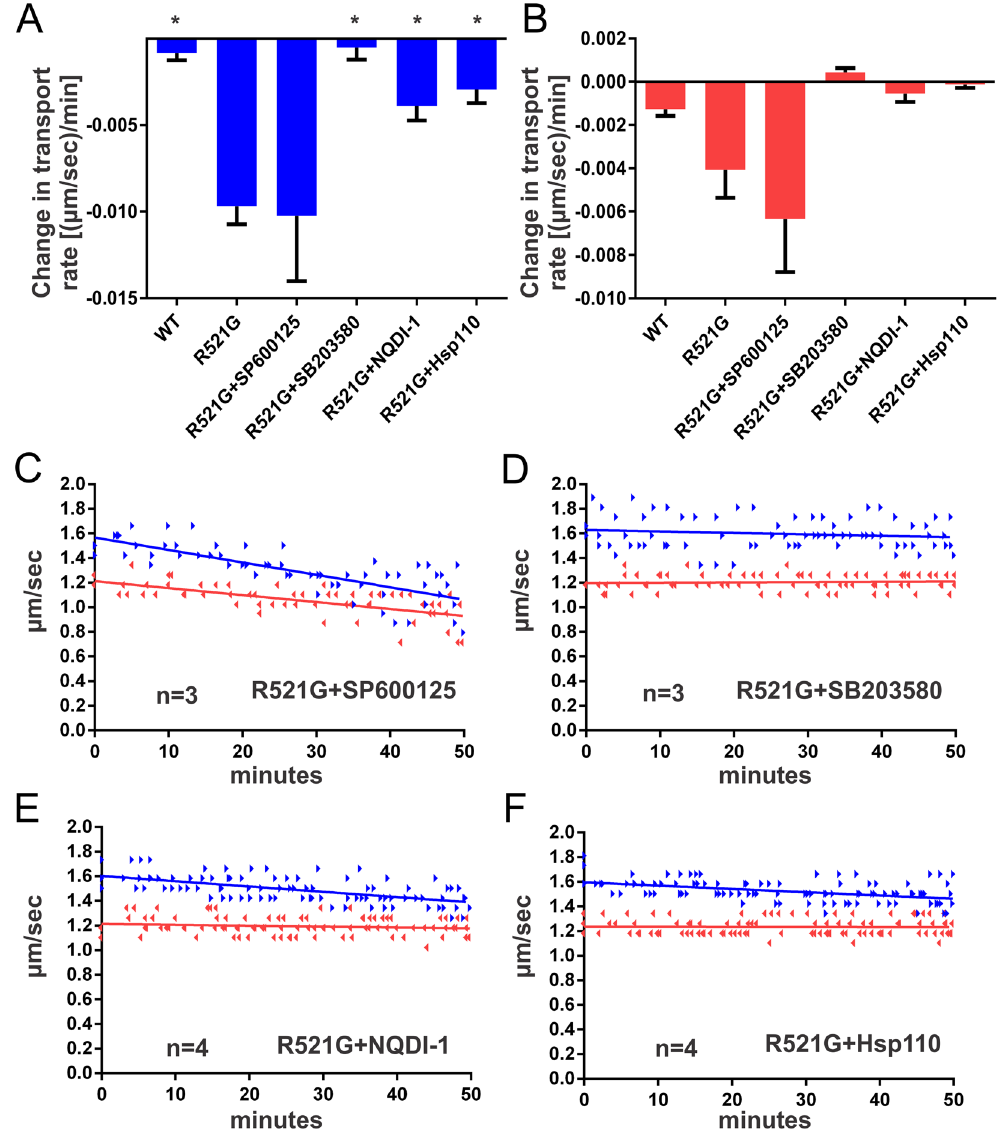
Figure 2. The inhibitory effect of mutant-FUS on FAT is mediated by activated p38 MAPK. FUS R521G was co- perfused with the indicated pharmacological inhibitor or Hsp110 into squid axoplasm and fast axonal transport evaluated as described in Fig. 1. ( A–C ) Co-perfusion of the pharmacological JNK kinase inhibitor SP600125 (0.5 μ M) with R521G failed to rescue FAT inhibition. In contrast, inhibition of the p38 MAPK pathway by co-perfusion of either SB203850 (5 μ M) or NQDI-1 (20 μ M) prevented the toxic effects of FUS R521G on FAT ( A , B , D , E ). ( F ) Similarly, co-perfusion of Hsp110 (0.6 μ M) and R521G ameliorated the inhibition of FAT by mutant FUS. Those conditions with statistical significance ( p < 0.05) relative to FUS R521G are denoted by * , determined by one-way Anova and Tukey post-hoc test for multiple